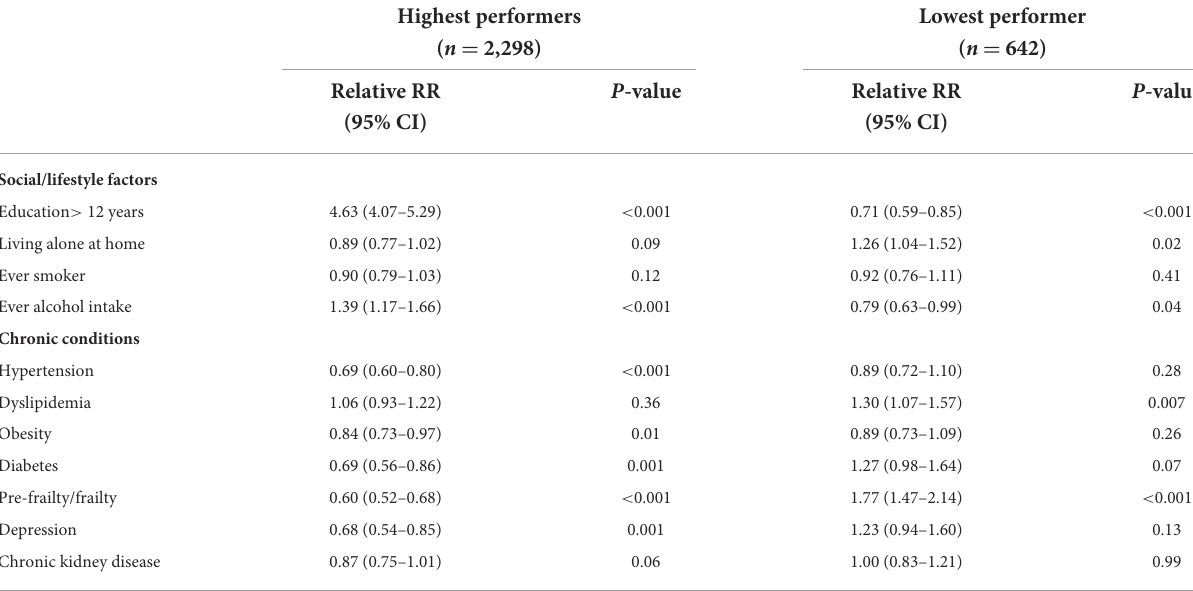
TABLE 2 Direct association between modifiable factors and cognitive trajectory subgroups, with reference to average performers * ( N =